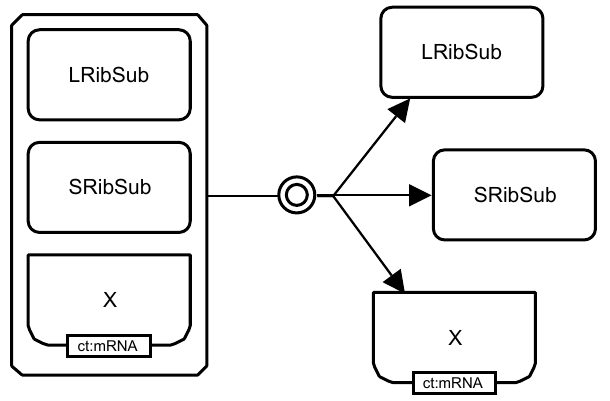
Figure 2.36: Dissociation of the small and large ribosomal subunits from a messenger